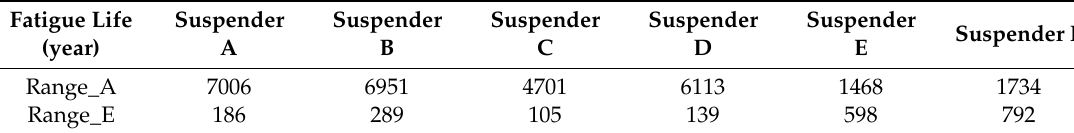
Table 7. Fatigue life estimation under di ff erent road roughness.